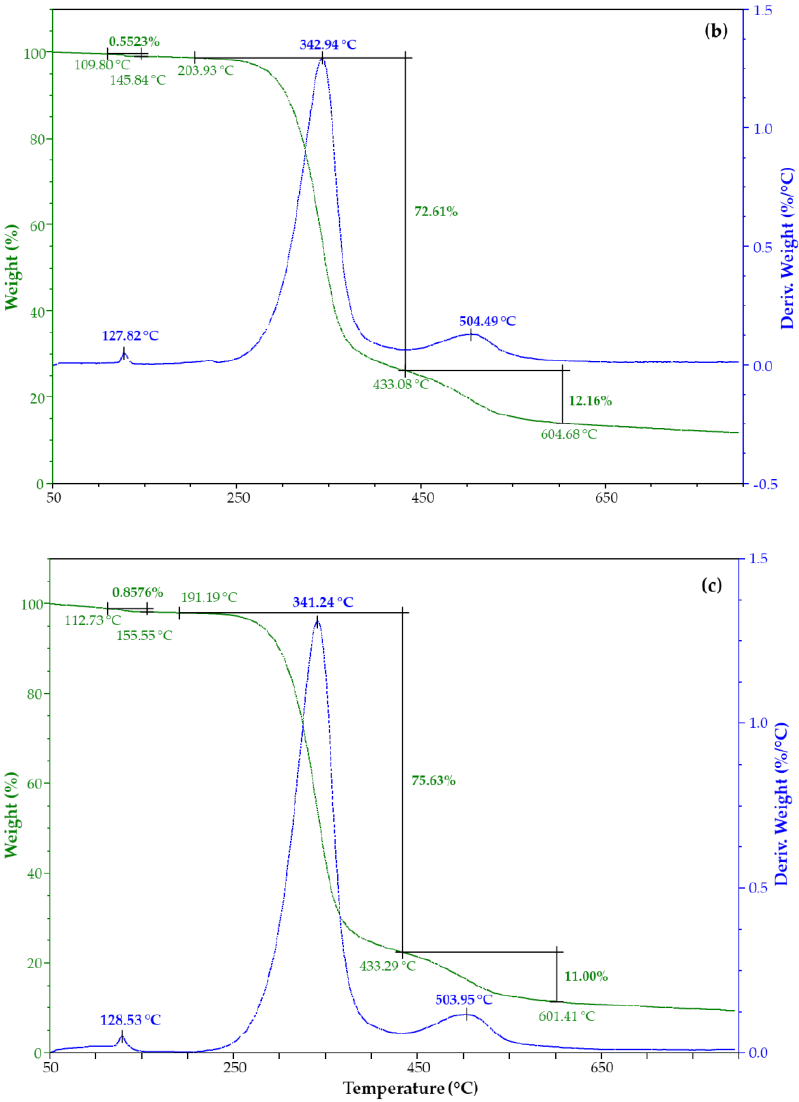
Figure 6. TGA and DTG of ( a ) CX and its complex from iodine, ( b ) water solution, and ( c )